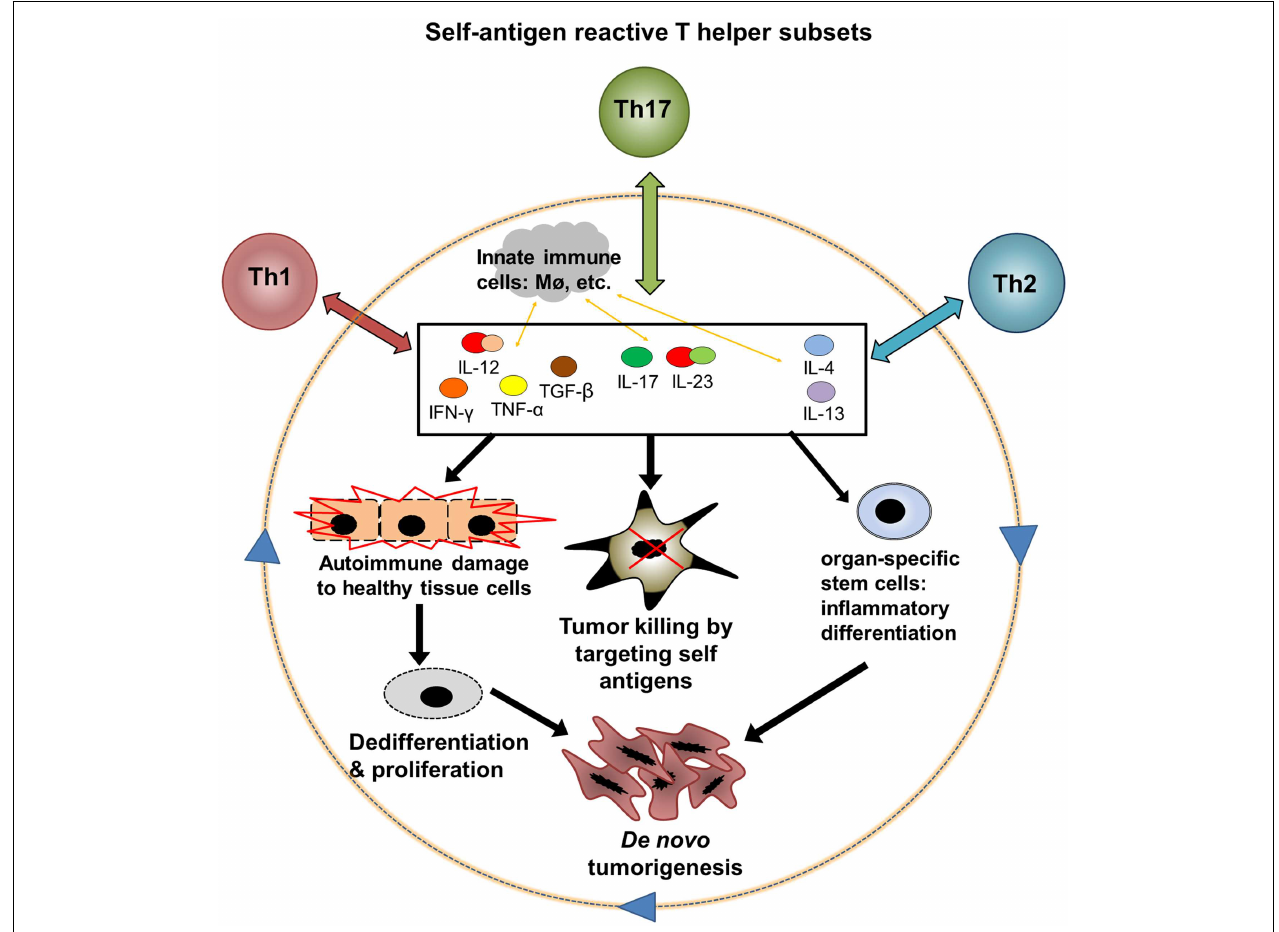
(3) Inflammation in healthy tissues, particularly when chronic, could contribute to loss of antiproliferative signals and aberrant differentiation in normal cells, leading to a premalignant phenotype. Continued proliferation of these abnormal cells, with accumulation of DNA damage, leads to the emergence of cancer. (4) Chronic cytokine signaling may induce abnormal differentiation of organ-specific stem cells or other precursor cells and drive a cascade of cancer development.The feedback between autoinflammation and cancer may particularly affect solid organs such as the gastrointestinal tract that are demonstrated to be susceptible to inflammatory